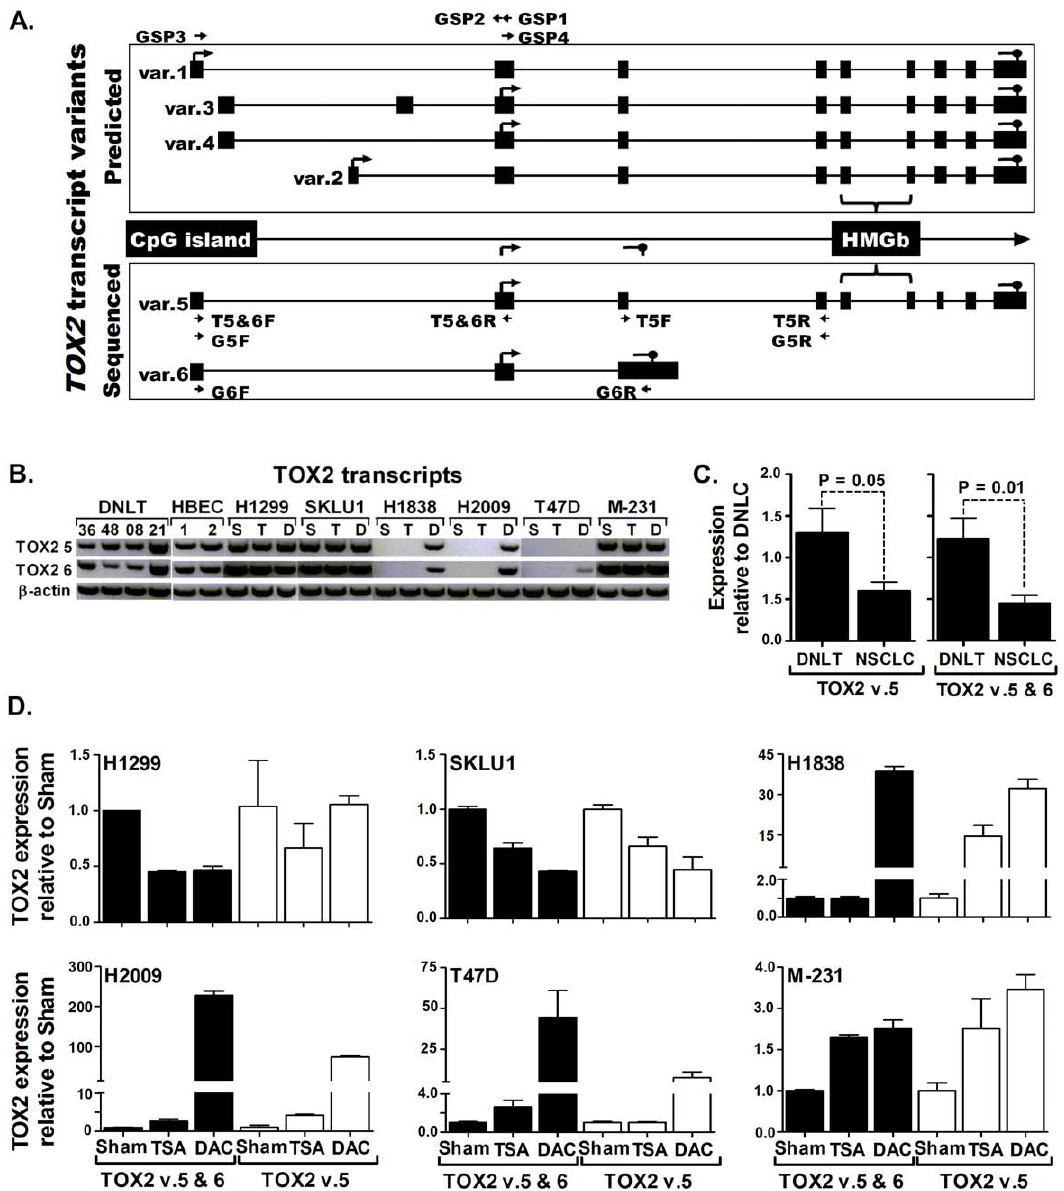
Figure 2. TOX2 expression in normal and cancer cells. ( A ) Genomic structure of TOX2 . Top box: Predicted transcript variants of TOX2 (var.1-4) currently used as reference sequence for Homo sapiens chromosome 20, GRCh37.p2, (GenBank accession number NC_000020.10). Bottom box: Transcripts sequenced from human cells (var.5 and 6). Small arrows indicate the location and direction of primer binding sites; T # F or T # R (forward or reverse primers for TaqMan assays) and G # F or G # R (forward or reverse primers for gel-based assays). ( B ) Expression of TOX2 transcript variants 5 and 6 and the house keeping gene beta-actin in distant normal lung tissue (DNLT), HBEC, and various lung and breast cancer cell lines. In Vehicle- treated (S, for sham) lung cancer (H1838, H2009) and breast cancer (T47D) cell lines with methylated promoter CpG island, both transcripts were silenced and expression of both was primarily restored with 5-Aza-2 9 -deoxycytidne (D) but not trichostatin A (T) treatment. ( C and D ) TaqMan assays that use distinct primer sets from those used for gel-based assays confirmed results shown in Figure 2B. ( C ) Expression of TOX2 var.5 or both (var.5 & 6) in lung tumors (n=20) relative to DNLT (n=10) obtained from NSCLC patients. ( D ) Expression of TOX2 var.5 or both (var.5 + 6) in TSA or DAC treated lung and breast cancer cell lines relative to Vehicle-treated (Sham) cell